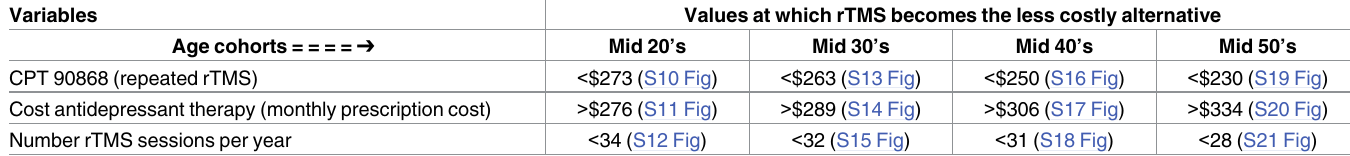
Table 3. One way sensitivity analysis–threshold values at which rTMS becomes the less costly alternative (S10–S21Figs available in supplemen- tal data section). Variables Values at which rTMS becomes the less costly alternative Age cohorts = = = = ➔ Mid 20’s Mid 30’s Mid 40’s Mid 50’s CPT 90868 (repeated rTMS) < $273 (S10 Fig) < $263 (S13 Fig) < $250 (S16 Fig) < $230 (S19 Fig) Cost antidepressant therapy (monthly prescription cost) > $276 (S11 Fig) > $289 (S14 Fig) > $306 (S17 Fig) > $334 (S20 Fig) Number rTMS sessions per year < 34 (S12 Fig) < 32 (S15 Fig) < 28 (S21